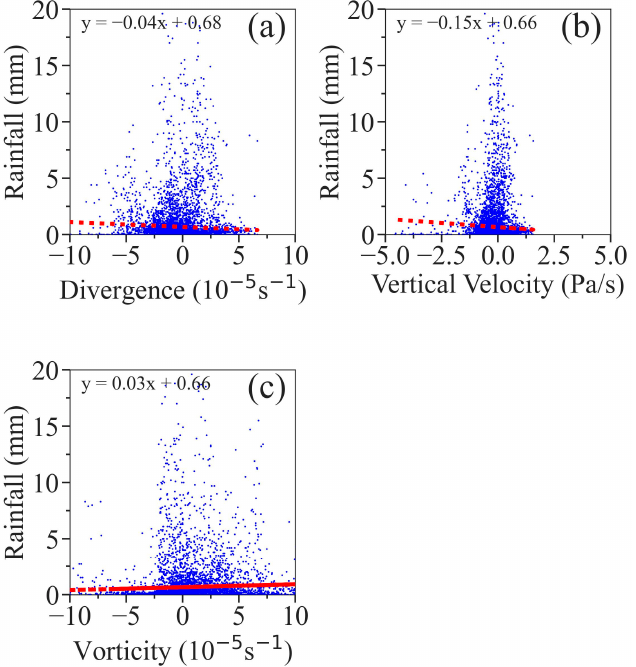
Figure 5. Scatter plots between rainfall amount at t = 0–10 min ( a ) divergence, ( b ) vertical velocity, and ( c ) vorticity retrieved from the RWP mesonet within 30 min before the onset of rainfall ( − 42– − 12 min). The regression lines are also shown.